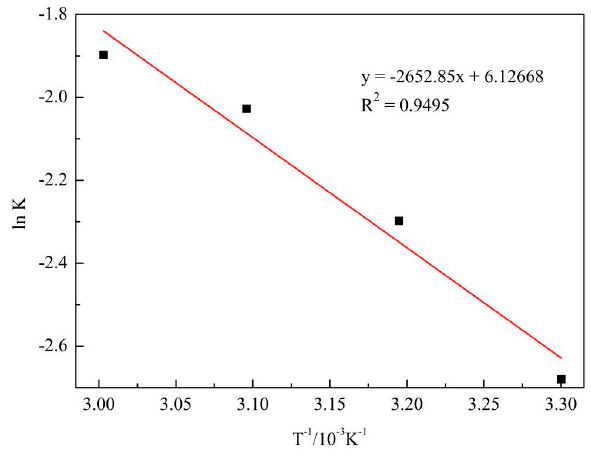
Figure 15. Plot of lnk vs. T − 1 in alkali fused SCC leaching process. Results shown in Figure 7 (right) were substituted into Equation (24) to yield the fitting results given in Figure 16 and Table 5.